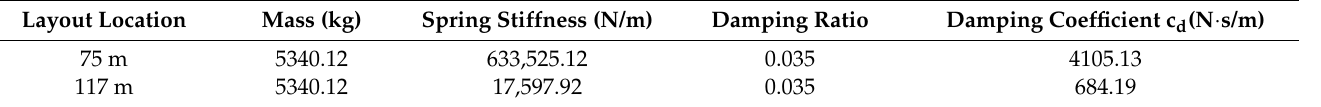
Table 2. Parameters of TMD.